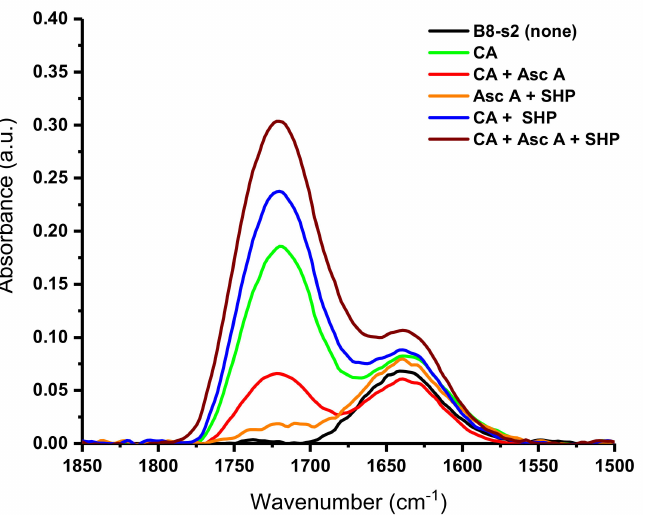
Figure 5. Fourier transform infrared spectra (1850–1500 cm − 1 ) of crosslinked bleached 100% cotton nonwoven fabric (B8-s2); black line shows no treatment; others show treatment with 9% citric acid (CA), 5% ascorbic acid (Asc A), and 3% sodium hypophosphite (SHP), and their various control